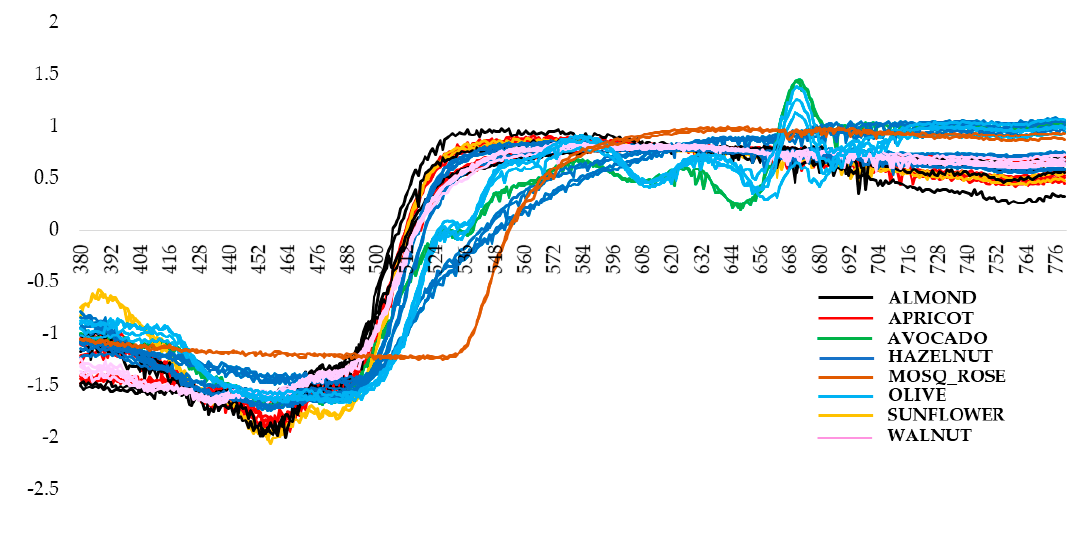
Figure 6. UV-Visible spectra of the different vegetal species after standard normal variate (SNV) pre-treatment of data. The PCA results on the 400 raw spectral variables (G 37,400 ), after SNV and mean centering, are shown in Figure 7.